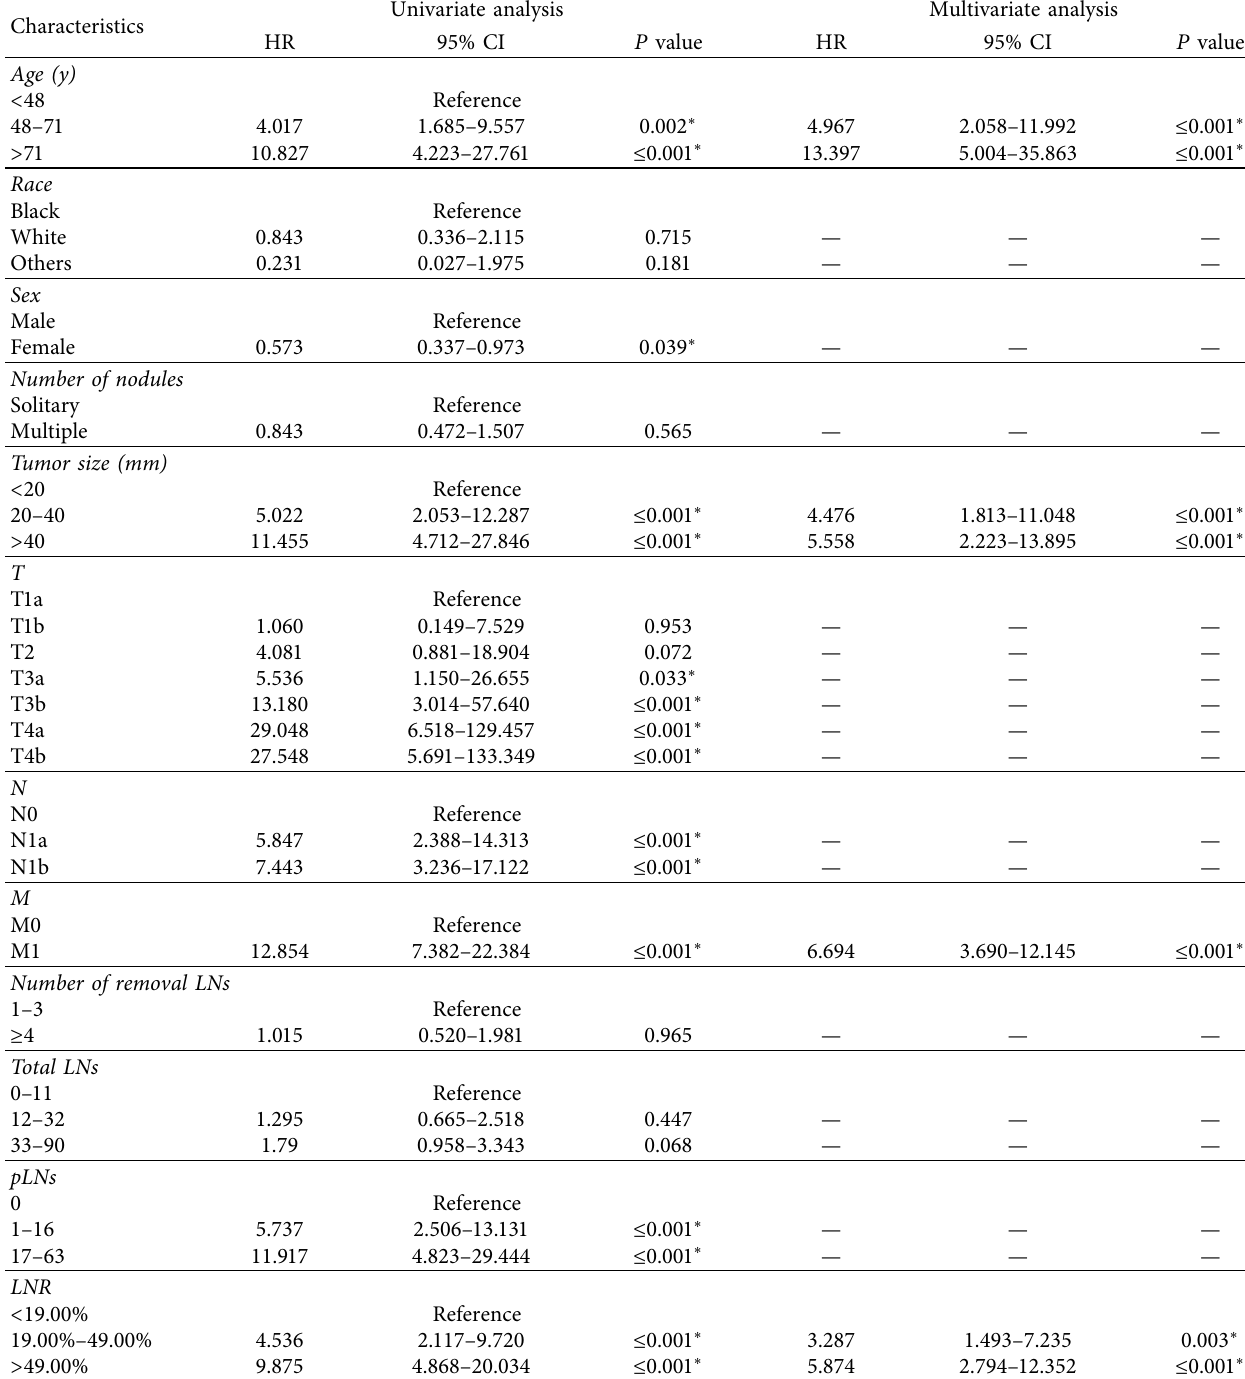
Table 3: Univariate and multivariate cox regression analysis of cancer-specific survival (CSS) in the training cohort.